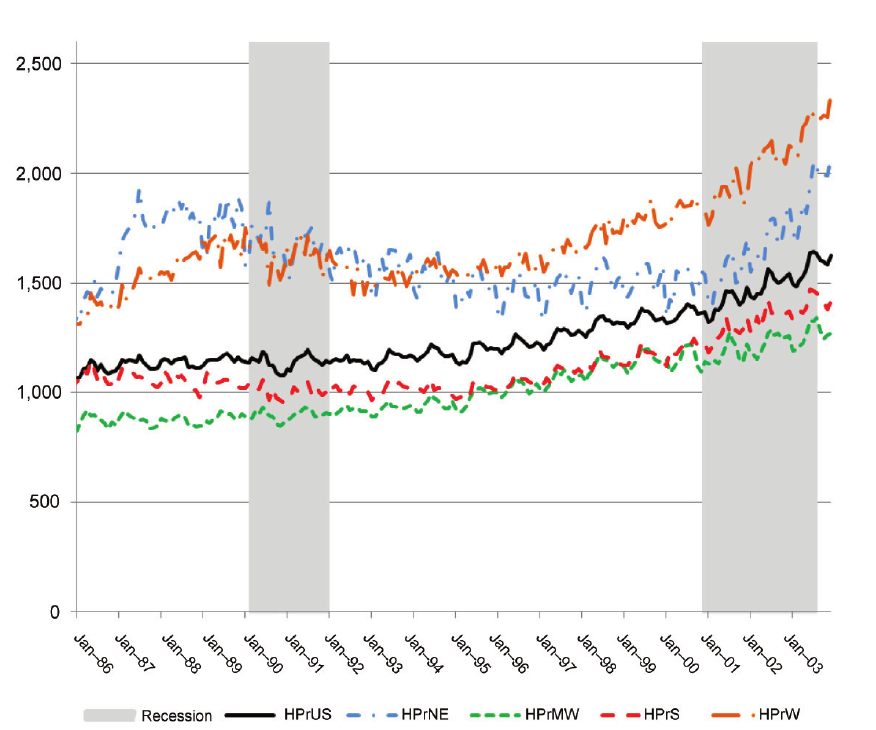
Figure 3. monthly housing